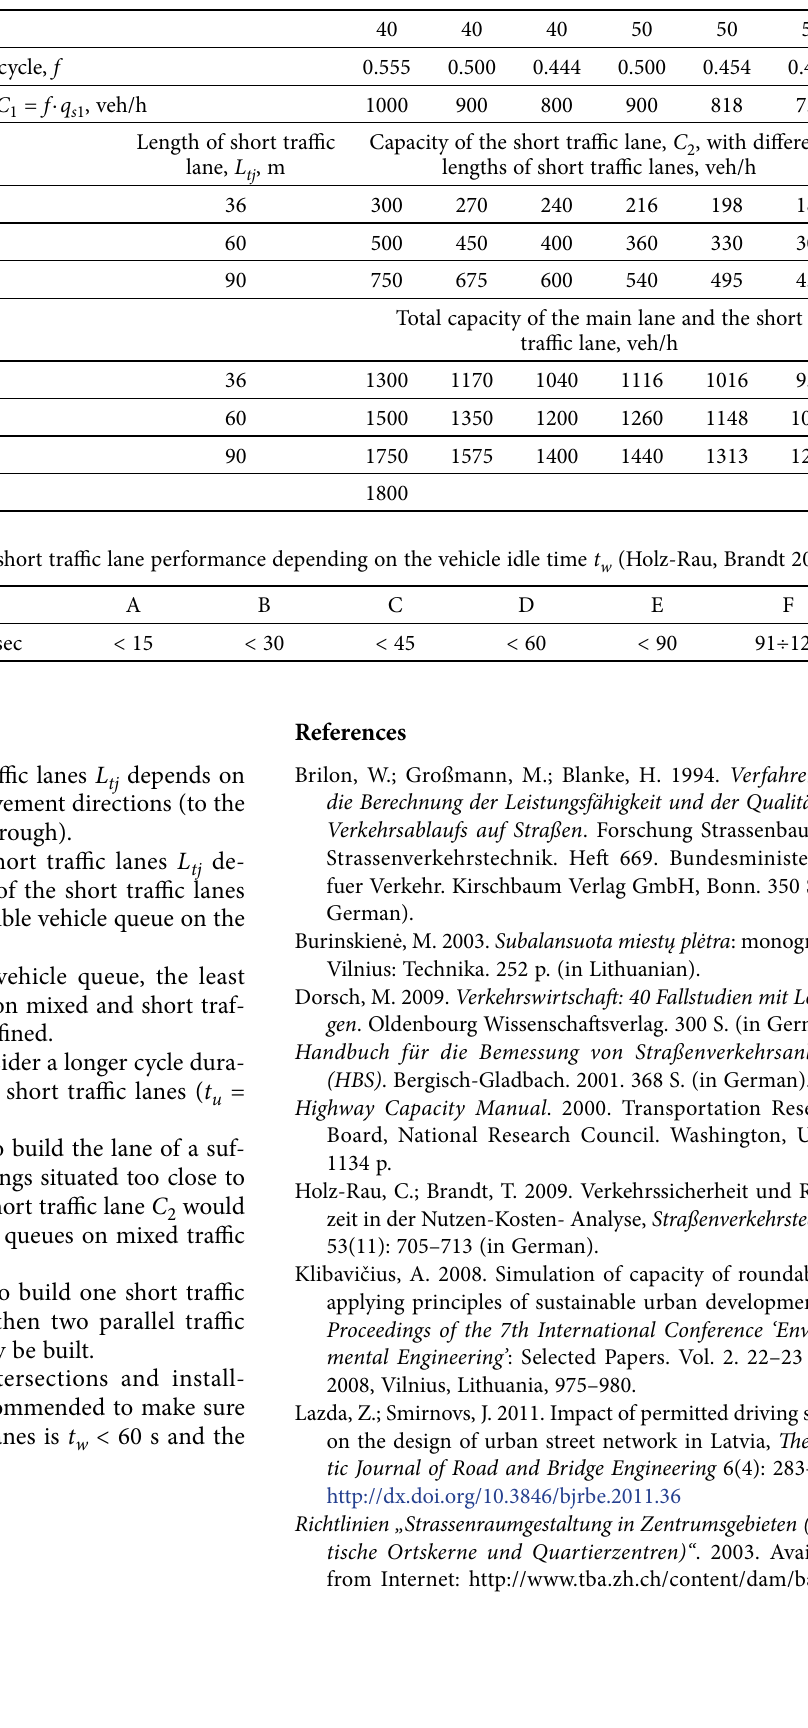
Table 4. Dependence of the total capacity of the main traffic lane and the short traffic lane on the length of the short traffic lane Number of cycles per hour, U Duration of the green interval, s Share of the green interval in the cycle, f